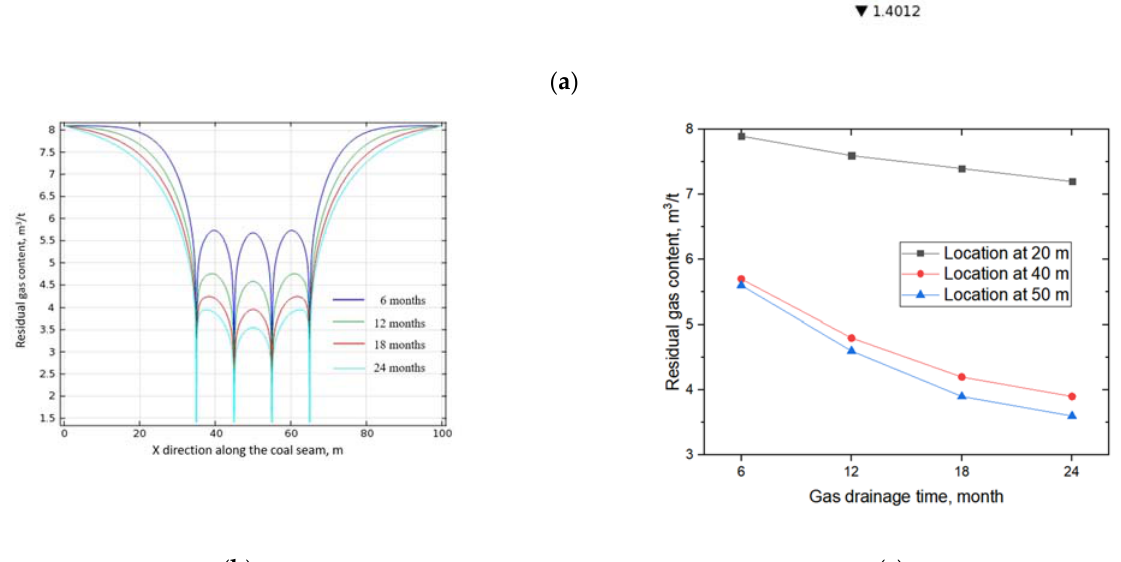
Figure 4. Simulation results for the 10 m borehole. ( a ) Gas content contour; ( b ) residual gas content with respect to X direction along the coal seam; ( c ) gas content at three points with respect to gas drainage time.